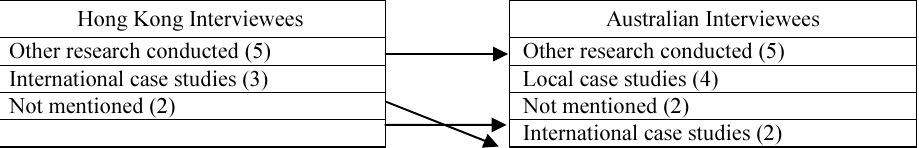
Table 6. Question 1 – Have you conducted any research looking at local case studies?